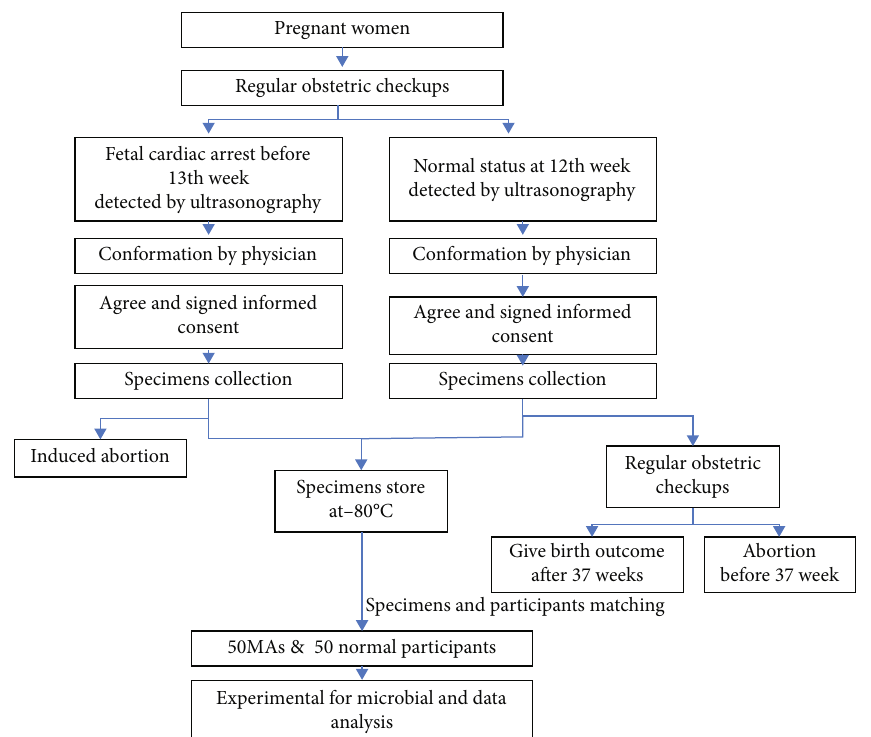
Figure 1: Procedures used in the study. Mas: missed